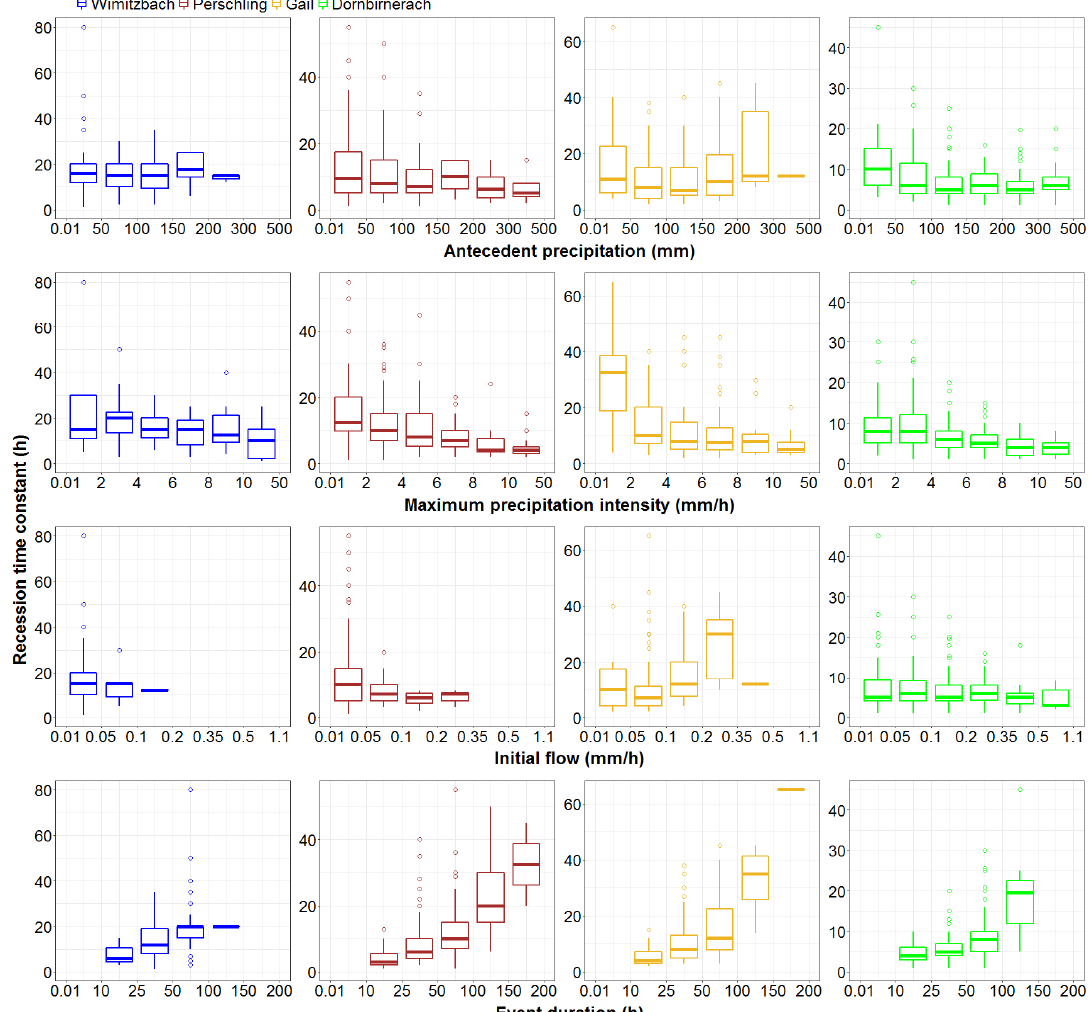
Figure 8. Variability of recession time constant (Tc) for different classes of antecedent precipitation, maximum precipitation intensity, initial flow prior to the event, and event duration in four selected catchments: Dornbirnerach, Gail, Wimitzbach, and Perschling. The changes are evaluated for events with precipitation volumes less than 50 mm.